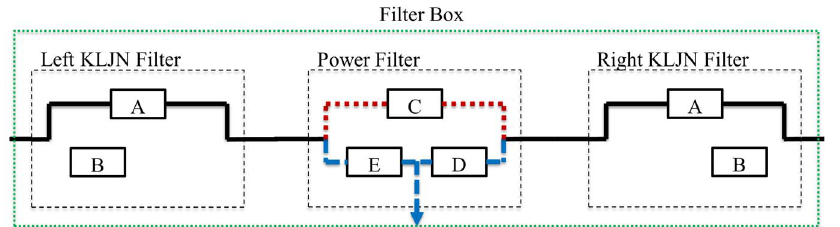
Figure 5. The filter box of the inactive host (when it is not executing KLJN key exchange): State 1. Everything is passing between left and right and the host can access only the power. Filter A is passing everything (shorted). Filter B is disconnected. Filter C is passing B kljn only. Filters and E and D are passing f p only. State 1 is when the host is not allowed to access KLJN band. State 2 is when the host is allowed to access KLJN band. This filter box is in State 1.